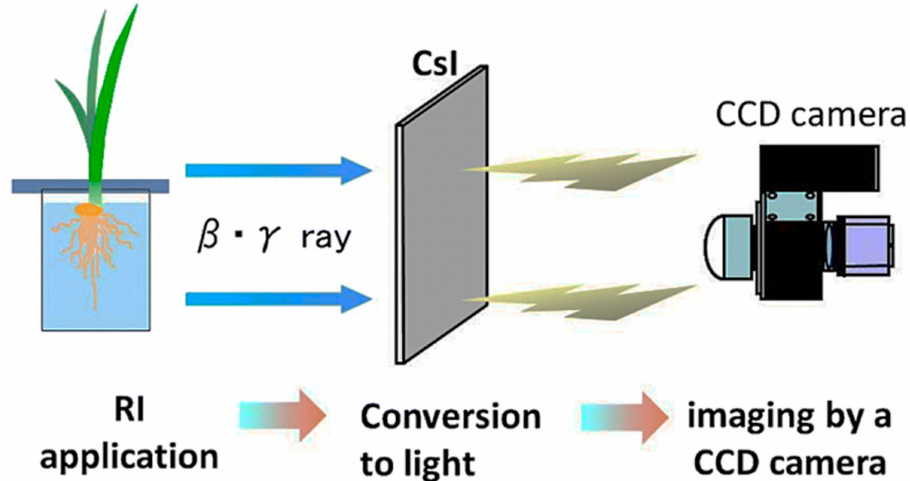
Figure 1. Schematic illustration of the real-time imaging system. After the application of the radioiso- topes to the plant, the radiation of the radioisotopes coming out from the plant was converted to light by a scintillator deposited on FOS (Fiber Optic Plate). Then, the light was introduced to a highly sensitive CCD camera to produce the radiation profile image. Since the light intensity is very weak and the sensitivity of the camera is high, initially, everything was kept in dark to protect the camera. Then, a plant box was prepared where only the above-ground part of the plant was illuminated by light and the plant box was sealed tightly to prevent the leakage of light. Now a chamber is prepared and the light was off when the CCD camera is on. Two imaging systems were prepared; one is for macroscopic and microscopic samples. To image an entire plant, from root to shoot, the macroscopic imaging system is used and for microscopic imaging, a modified fluorescent microscope is used to obtain three images simultaneously, light, fluorescent and radioisotope images. This schematic is reproduced from the study by Nakanishi